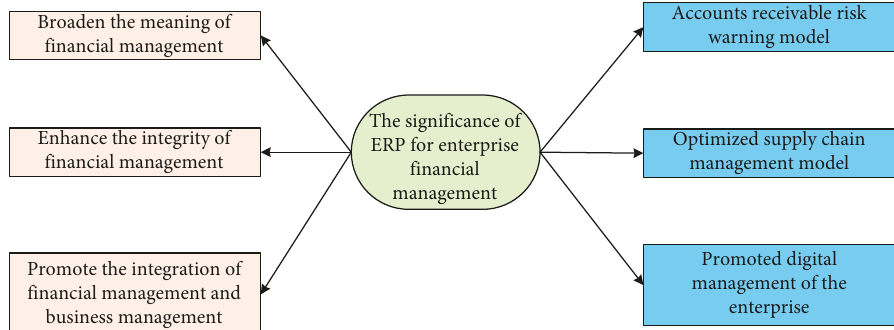
Figure 1: The significance of ERP for enterprise financial